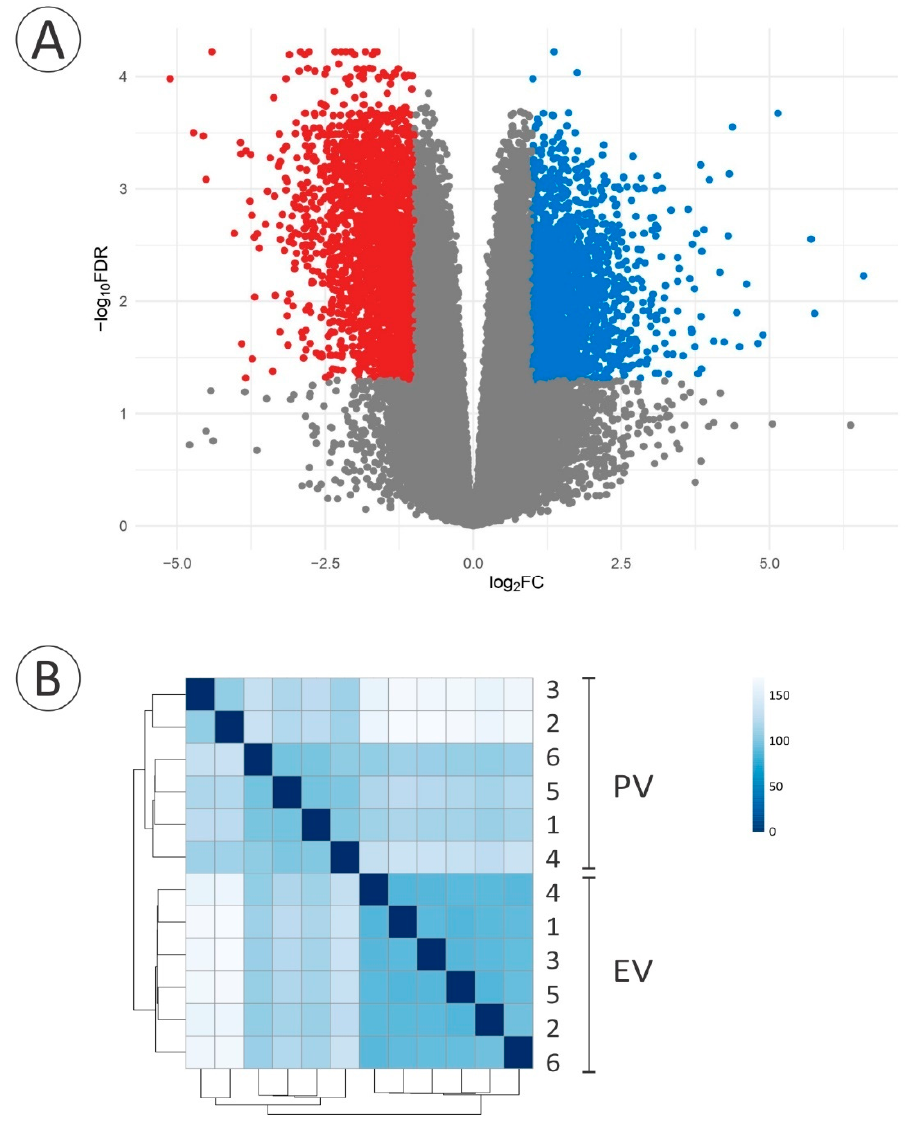
Figure 3. ( A ) Volcano plot displaying significant differentially expressed genes between A. australis ovarian tissue in the PV and the EV stage. Under the selected cut-off ( q value < 0.05; − 1 ≥ log 2 FC ≥ 1), a total of 4878 genes were differentially expressed out of 32,447 genes. While 2027 genes were down-regulated (blue dots), 2851 genes were up-regulated (red dots) during the PV-EV transition. ( B ) Heatmap showing the clustering of samples by Euclidean distance. Each sample (numbered 1–6) represents a biological replicate corresponding to the PV or the EV stage.